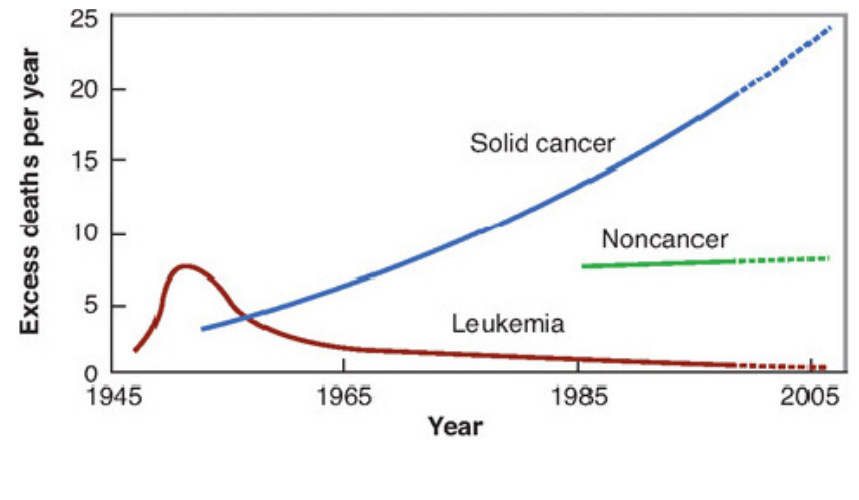
Figure 1. Time course of SMN development following A-bomb explosion in 1945. Leukemia appeared first followed by solid cancers several years later. There was also an excess of non-cancer deaths from stroke and heart disease by the late 1980s (courtesy of Kiyohitko Mabuchi, National Institutes of Health,